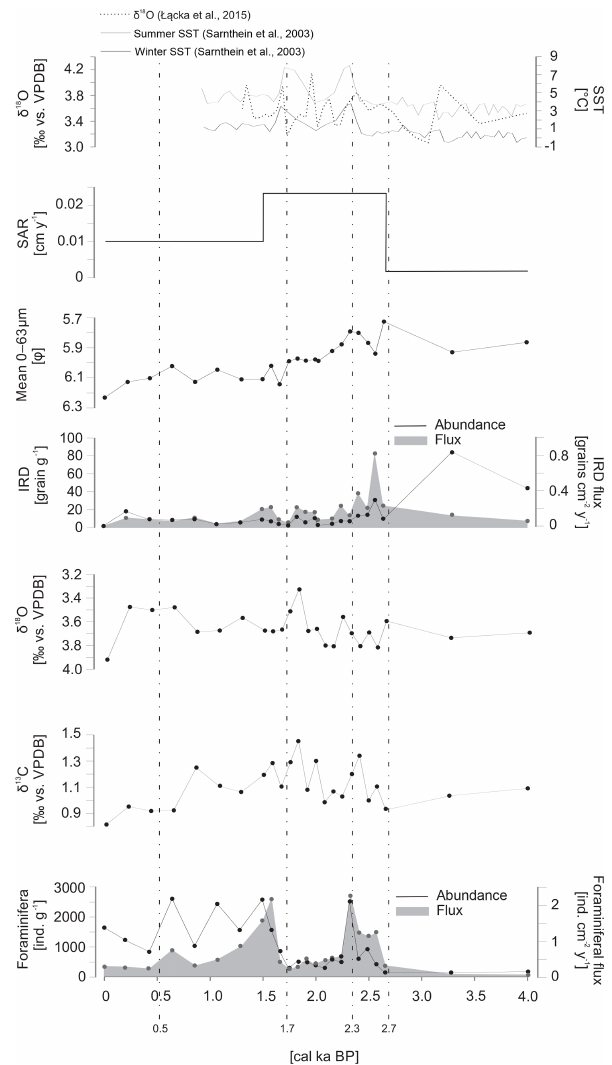
Figure 4. Sedimentological and micropaleontological data plotted versus age. The sediment accumulation rate (SAR), mean grain size of the 0–63µm fraction, ice-rafted debris (IRD) flux and number of grains per gram of sediment, oxygen ( δ 18 O) and carbon ( δ 13 C) stable isotopes in benthic foraminiferal tests, and the flux and abun- dance of foraminifera are